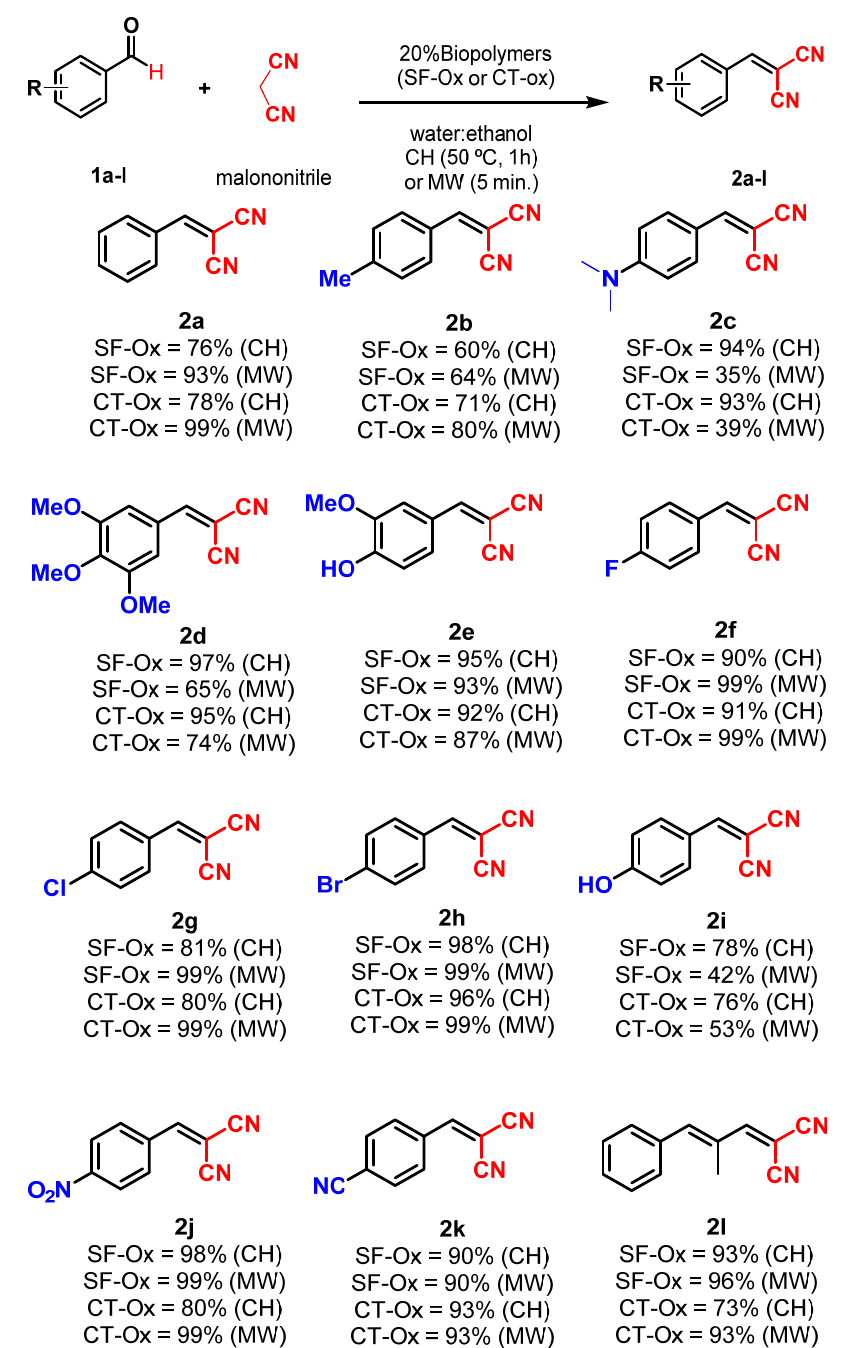
Figure 2. Knoevenagel condensation synthesis using aromatic aldehyde derivatives, malononitrile and immobilized biopolymers with Oxone ® as catalysts under conventional heating (CH) or with microwave irradiation (MW) as a heating source.